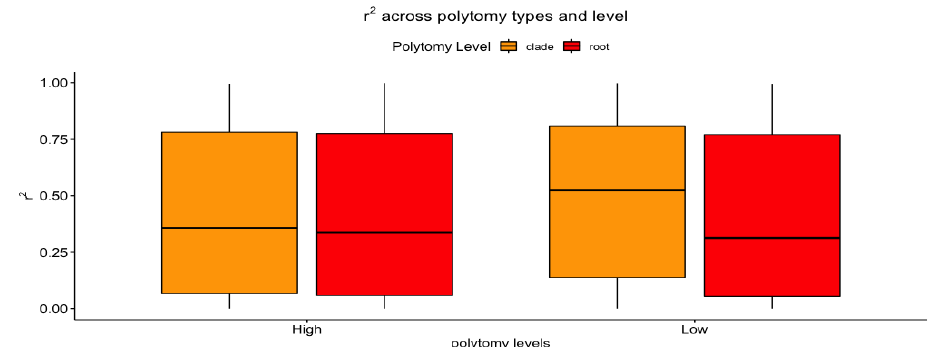
Figure 10. Box plots of r 2 by polytomy type and level conditioned through polytomy type and polytomy